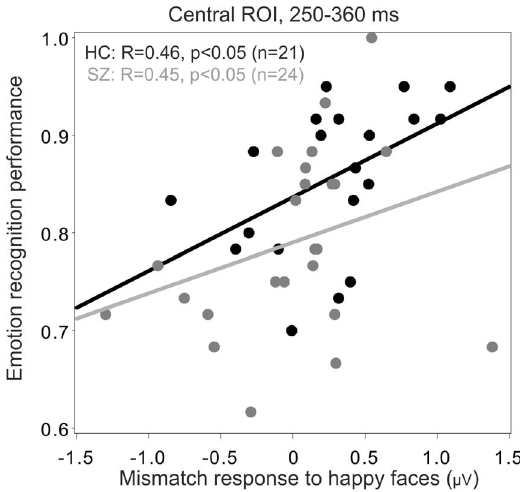
Figure 4. Association between recognition accuracy and mismatch responses. Subjects with Schizophrenia: Grey, Control Subjects: Black; ROI=Region of Interest. More positive mismatch signals were associated with higher recognition rates in this